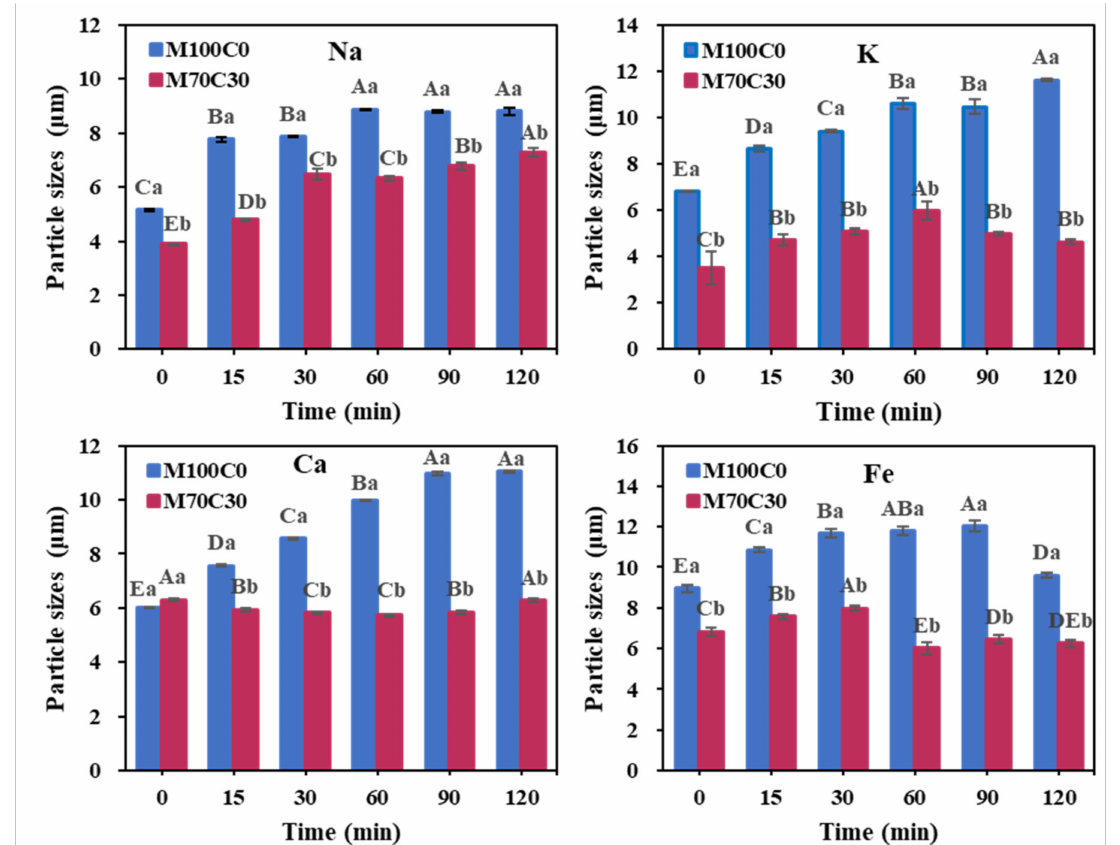
Figure 6. Particle sizes of the two emulsions with different ions after digestion. Different capital letters represent significant differences in the adsorption rate of the same emulsion with different ionic strengths. Different lowercase letters represent significant differences in the adsorption rate of different kinds of emulsion with the same ionic strength. p <